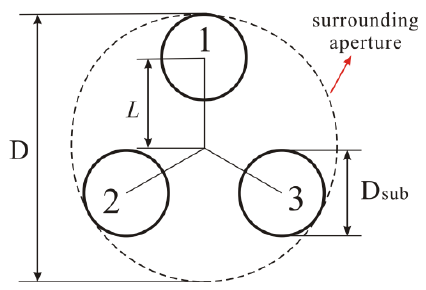
Figure 1. The Golay3 aperture.